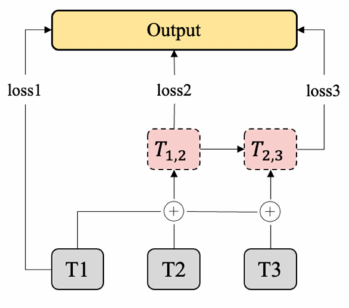
Figure 5. Multi-loss constraint